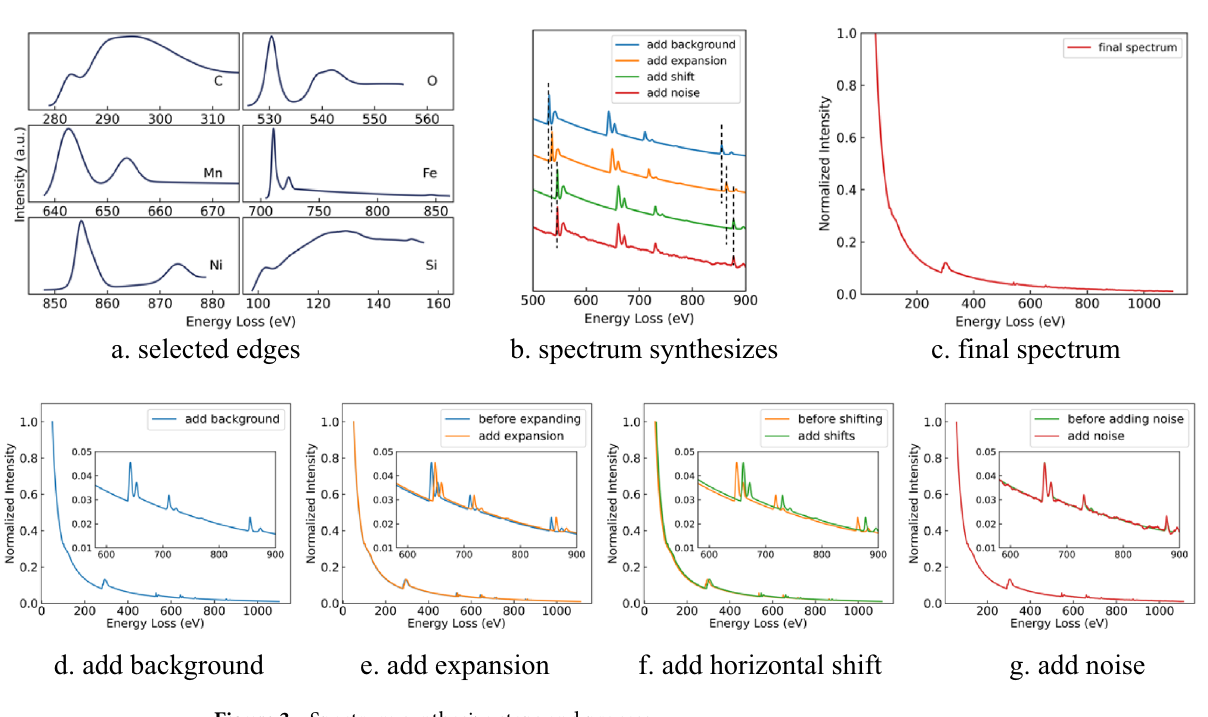
Figure 3. Spectrum synthesize steps and